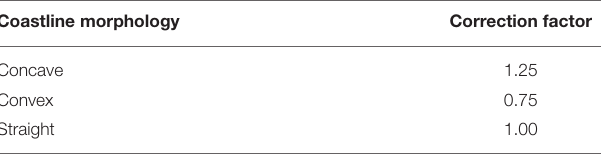
TABLE 3 | Coastline morphology and the corresponding correction factors used to calculate